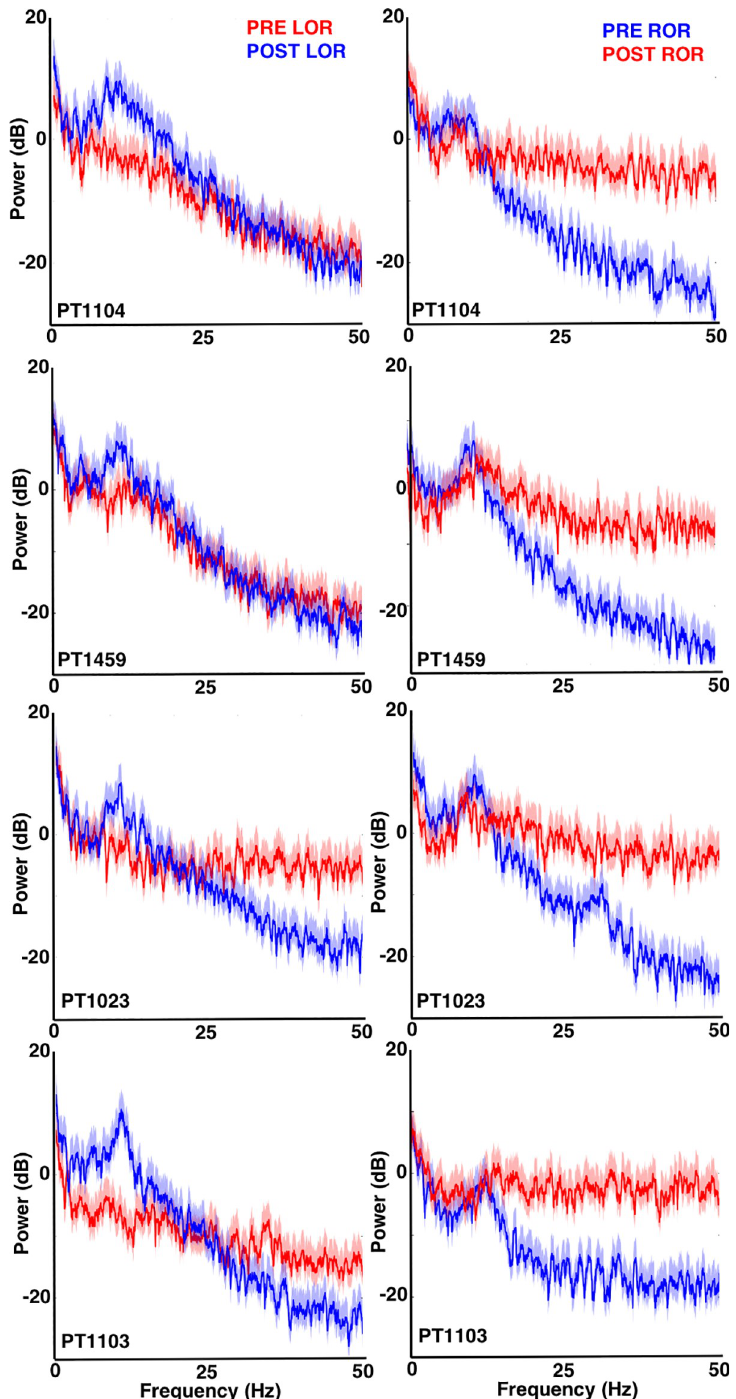
Fig 2. Power Spectra before and after loss and recovery of response. Power spectra around loss (left) and recovery (right) of response from four individual patients is shown. Awake or responsive periods (pre-LOR in left column and post-ROR in right column) are in red while anesthetized periods (post-LOR in left column and pre-ROR in right column) are in blue. The responsive state (red) is characterized by higher power in the frequency bands > 12 Hz, while the anesthetized or LOR state is characterized by higher power in the slower frequency bands < 12 Hz, with peaks in the delta (1–4 Hz) and alpha (8–12 Hz) band range, previously defined as slow-wave anesthesia (SWA). Solid red and blue lines indicate the mean value at each frequency, while the shading indicates a 95% confidence interval using a theoretical error distribution. https://doi.org/10.1371/journal.pone.0223921.g002 PLOS ONE | https://doi.org/10.1371/journal.pone.0223921 October 30,